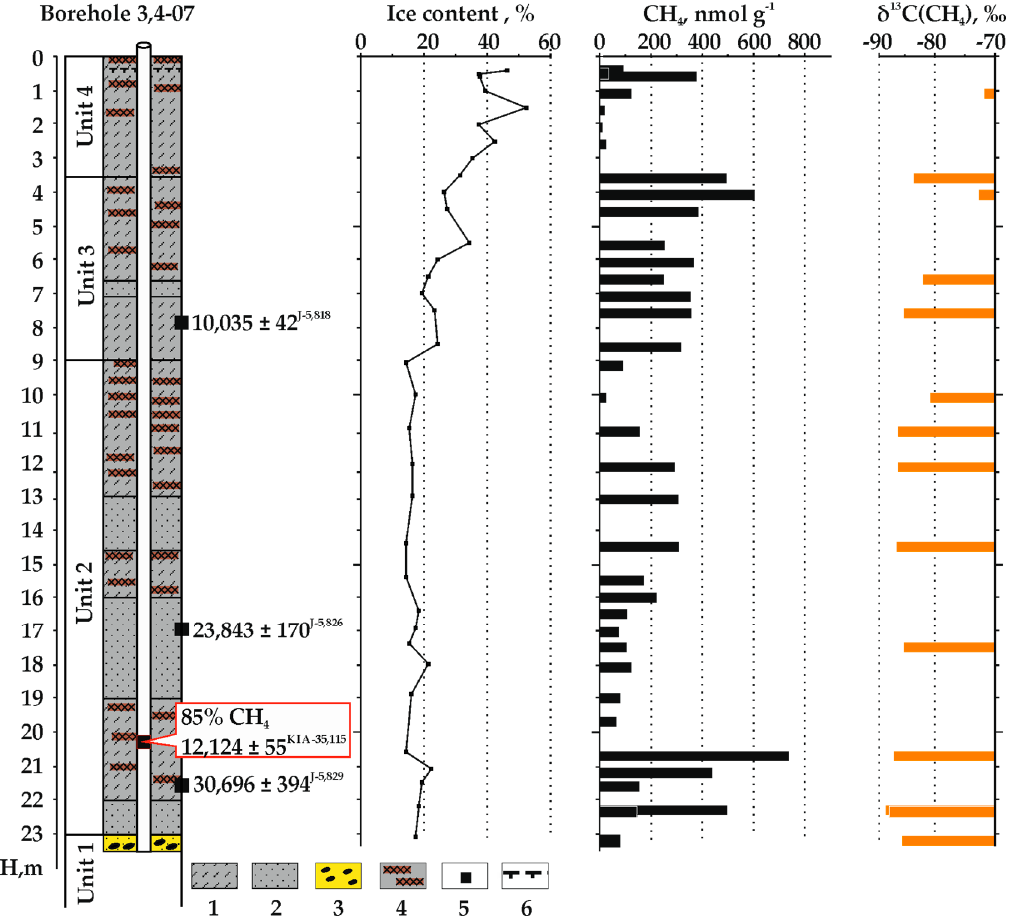
Figure 2. Soil composition, CH 4 concentration (shown by bars) and stable carbon isotopes (shown by circles) of CH 4 , radiocarbon dates of dissolved organic matter and CH 4 from the gas filling borehole 3,4-07. Key: 1, silts; 2, sands; 3, gravel; 4, peat; 5, radiocarbon dating samples; 6, permafrost table. Unit numbers define the geological layers, described in the text. Initial data are presented in Table A1.